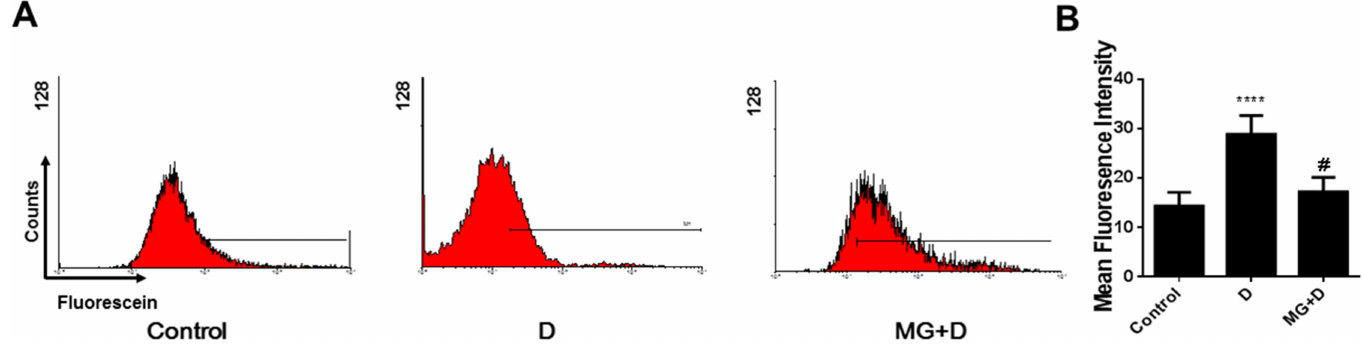
Fig 3. GB pretreatment decreasedthe level of reactiveoxygen species (ROS) in cardiomyocytes treated with DOX. ( A ) Flow cytometry analysisof ROS level in cardiomyocytes treated with 5 μ M GB (MG) before subjectionto DOX inducedcardiotoxicity. ( B ) Quantification of the mean fluorescence intensity (MFI) obtained from Flow cytometry. **** p < 0.0001 when comparedto control group, #p < 0.0001when comparedto